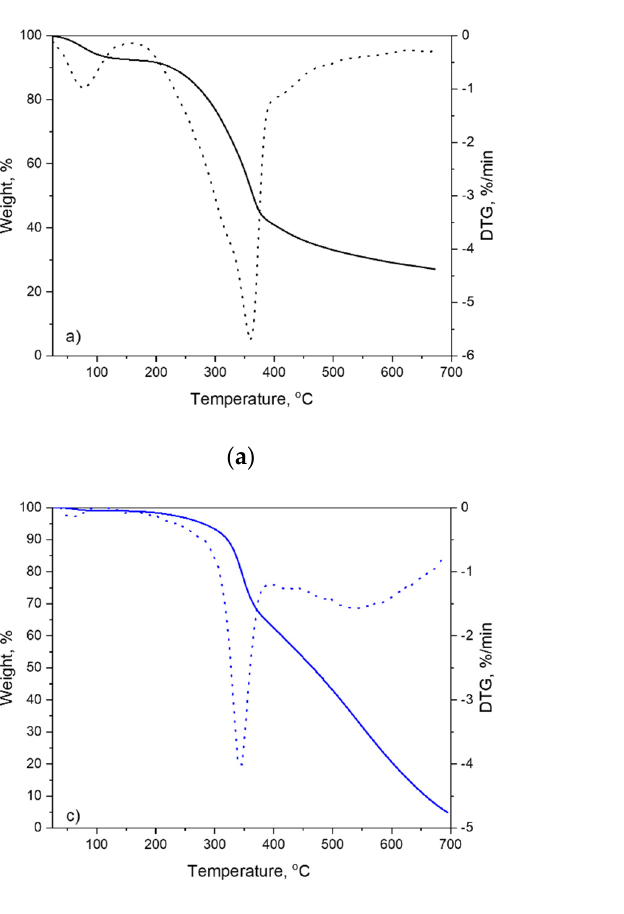
12 of 18 Figure 7. Adsorption-desorption isotherms of nitrogen for ( a ) HC-200; ( b ) HC-240; ( c ) HC-280. Table 6. Specific surface area and porosity of hydrochars. Sample